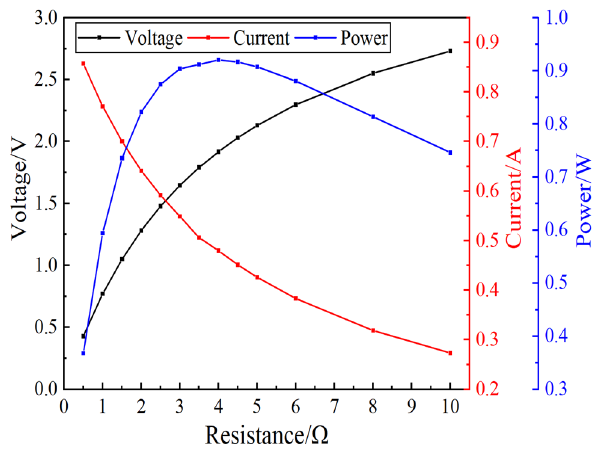
Figure 5. Electrical characteristics under 140 °C.